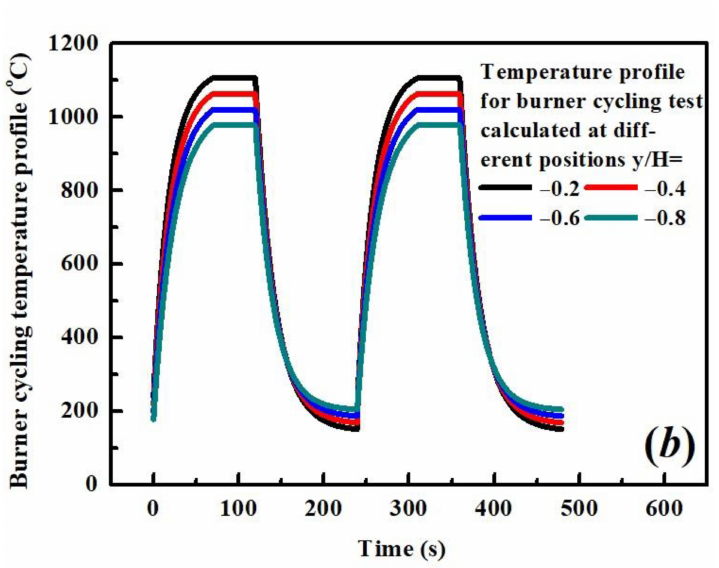
Figure 2. Temperature profile calculated using Equation (1) for burner cycling test. ( a ) The solid curves are calculated temperatures at TC/BC surface and the dot points are measured temperature from test data [8]. ( b ) Solid lines are the calculated temperature curves across TC including thermal gradient effect.